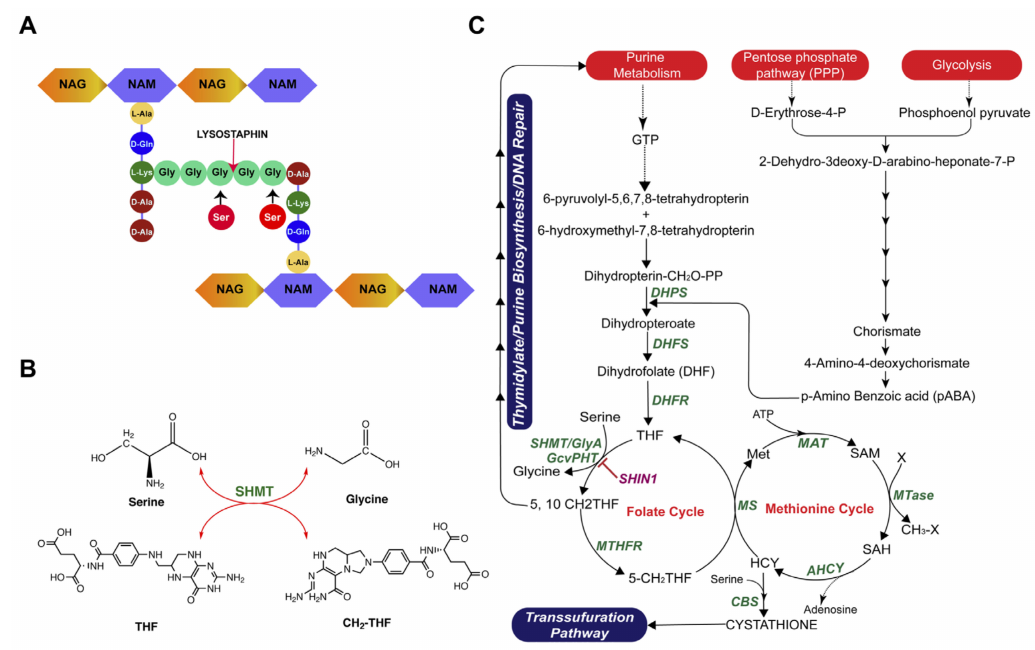
Figure 4. Novel mechanism of lysostaphin resistance in ST72 isolate and its associated metabolic pathway. After screening all the possible genes and mutation(s) known for lysostaphin resistance, no existing mechanisms (genes, mutations) of lysostaphin resistance was found to be functioned in ST72. ( A ) The schematic diagram shows the fundamental reason of lysostaphin resistance in staphylococcal cells due to the modification of glycine residues of pentaglycine bridge to serine; ( B ) Serine hydroxymethyltransferase (SHMT) is an indispensable enzyme for the one-carbon metabolism of serine / glycine interconversion and is linked to folate / methionine cycle. Therefore, glyA / shm T gene was hypothesized to be involved in lysostaphin resistance. ( C ) The metabolic pathway showing the interdependence of folate / methionine cycle and the key role of shmT serine / glycine homeostasis. One-carbon metabolism is responsible for the transfer of methyl group to various substrate and cofactors in folate, methionine cycle, and transsulfuration pathways. Various enzymes are denoted in green font while the substrates are depicted in regular font. The abbreviation used in the pathway wherein enzymes are DHPS (Dihydropteroate synthase); DHFS (Dihydrofolate synthase); DHFR (Dihydrofolate reductase); SHMT (Serine hydroxymethyltransferase); GcvPHT (glycine cleavage system); MTHFR (Methylene tetrahydrofolate reductase); MS (Methionine synthase); MAT (Methionine adenosyltransferase); MTases (Methyl transferases); AHCY (S-adenosylhomocysteine hydrolase), and CBS (Cystathionine beta-synthase) and substrates are THF (Tetrahydrofolate); 5, 10 CH 2 -THF (5, 10 methylene tetrahydrofolate); 5-CH 2 -THF (5-methylene tetrahydrofolate); Met (Methionine); SAM (S-adenosyl methionine); SAH (S-adenosyl homocysteine), and HCY (Homocysteine). One-carbon metabolism is important in cellular homeostasis by maintaining cellular seine / glycine through folate cycle, methionine cycle (protein synthesis), DNA synthesis and repair, redox balance, and various methylation